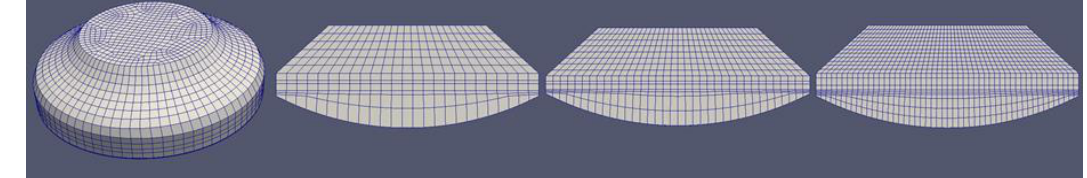
Figure 2. 3D simulation mesh and 2D simulation meshes.